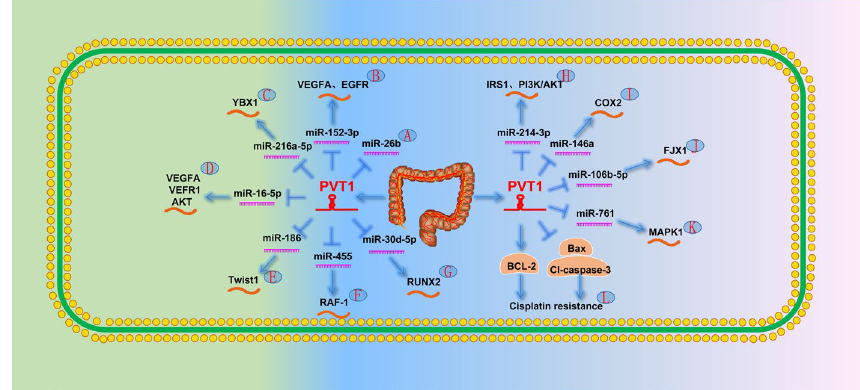
Fig. 4 The role of PVT1 in the digestive system [3]. A PVT1 directly targets miR-26b. B PVT1 promotes the expression of VEGFA and EGFR by targeting miR-152-3p. C PVT1 promotes YBX1 expression by targeting miR-216a-5p and ultimately leads to EMT in CRC cells. D By targeting miR-16-5p, PVT1 leads to increased VEGFA, VEGFR1, and AKT expression and ultimately leads to EMT in CRC cells. E PVT1 ultimately promotes EMT in CRC cells by targeting miR-186 and leading to increased Twist1 expression. F PVT1 promotes RAF-1 by targeting miR-455. G PVT1 promotes the expression of RUNX2 by targeting miR-30d-5p. H PVT1 upregulates IRS1 by targeting miR-214-3p and ultimately activates PI3K/AKT signaling pathway. I PVT1 promotes the expression of COX2 by targeting miR-146a. J PVT1 promotes the expression of FJX1 by targeting miR-106b-5p. K PVT1 promotes the expression of MAPK1 by targeting miR-761. L PVT1 promotes the occurrence of EMT in CRC cells by downregulating the pro-apoptotic proteins Bax and Cl-caspase-3 and upregulating the expression of the anti-apoptotic protein